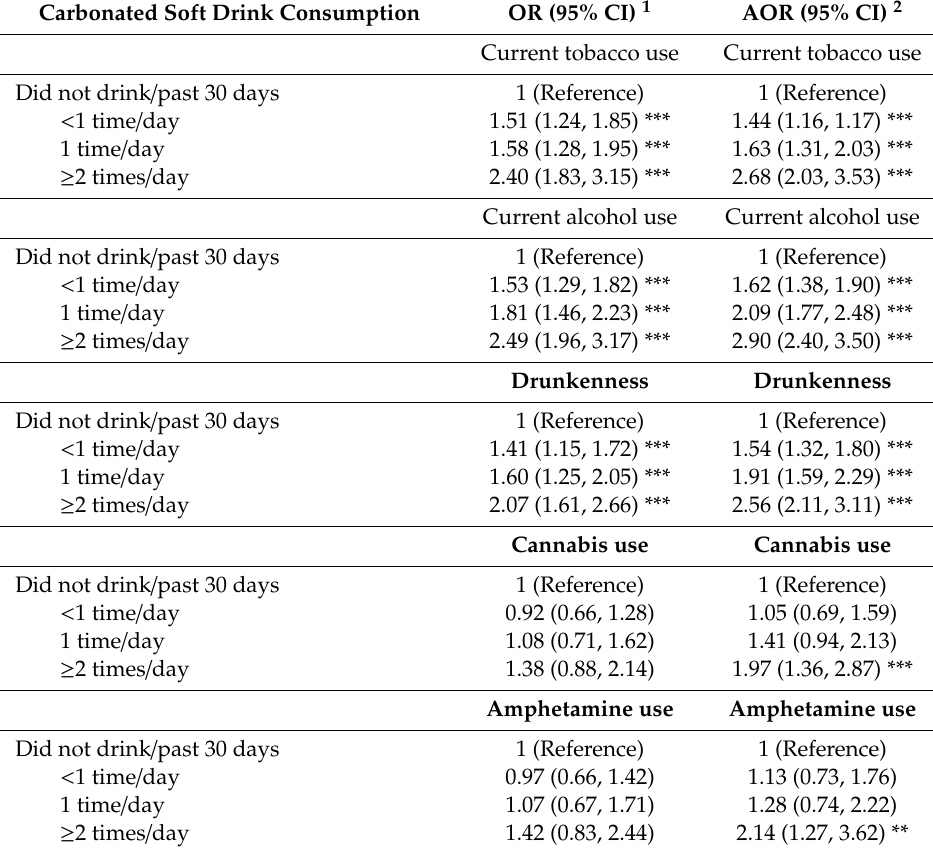
Table 4. Associations between soft drink use frequency and substance